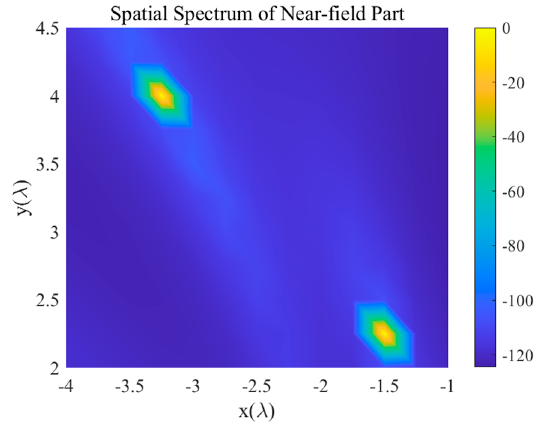
Figure 4. The spatial spectrum of the near-field part under SNR of 10 dB and INR of 50 dB.